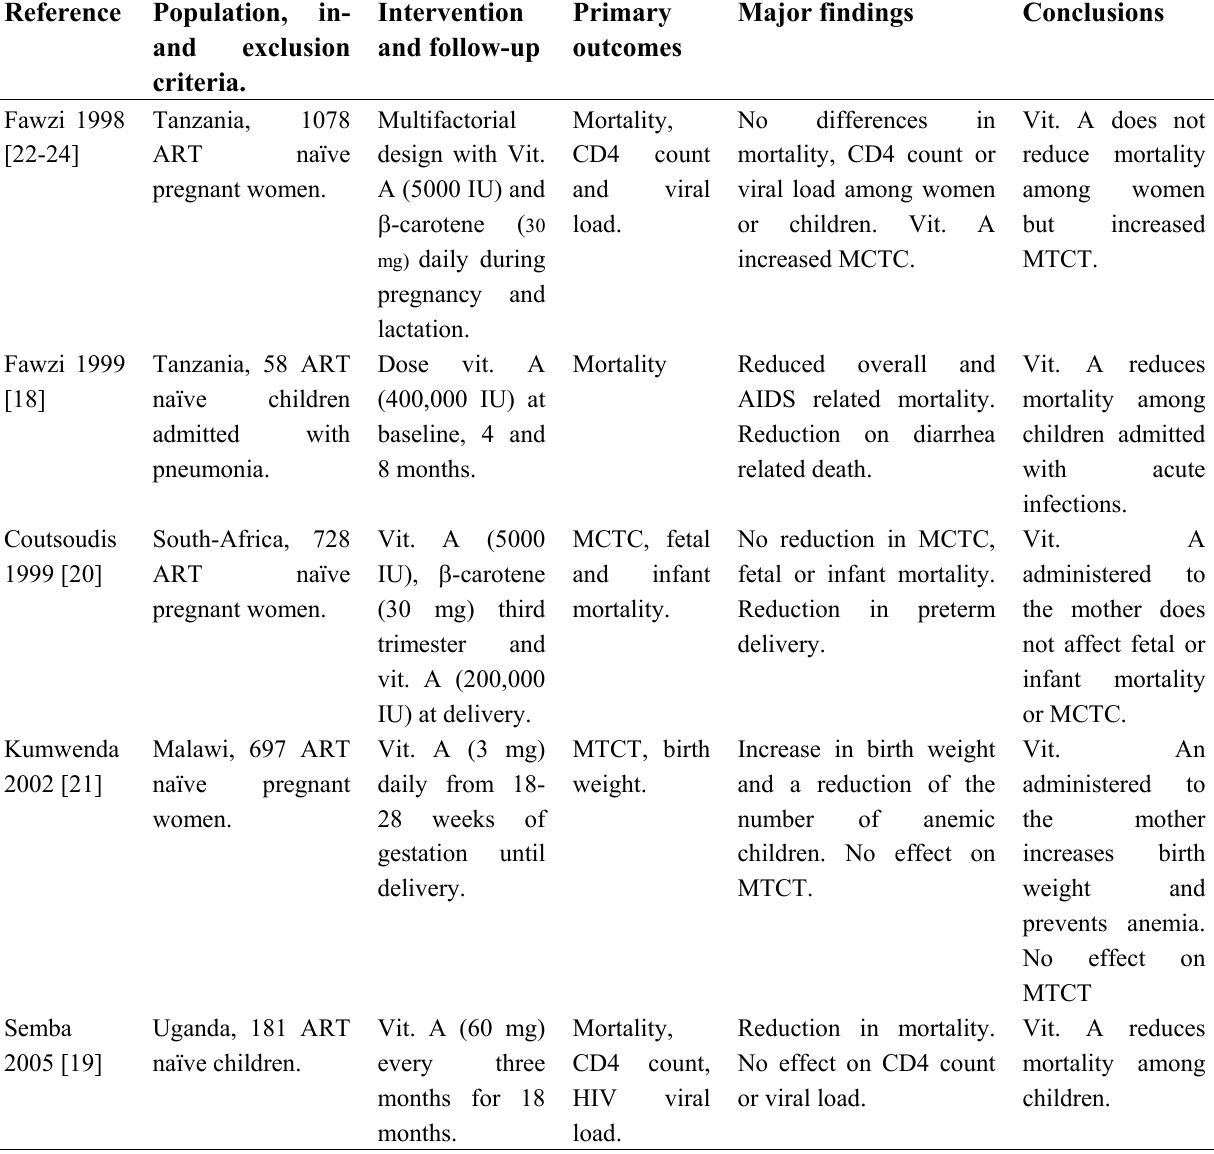
Table 1. Randomized controlled trials on vitamin A and HIV